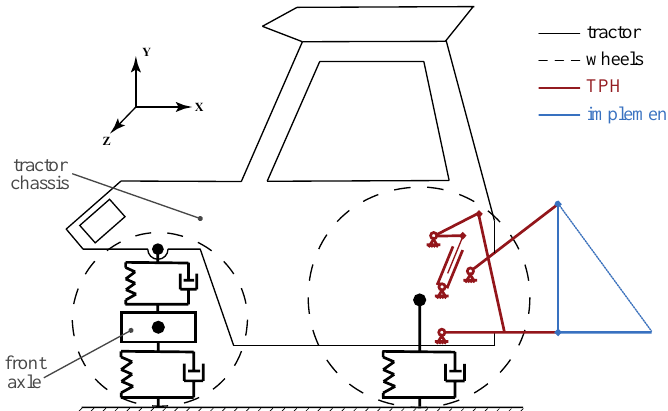
Figure 1. The tractor – TPH – implement model.